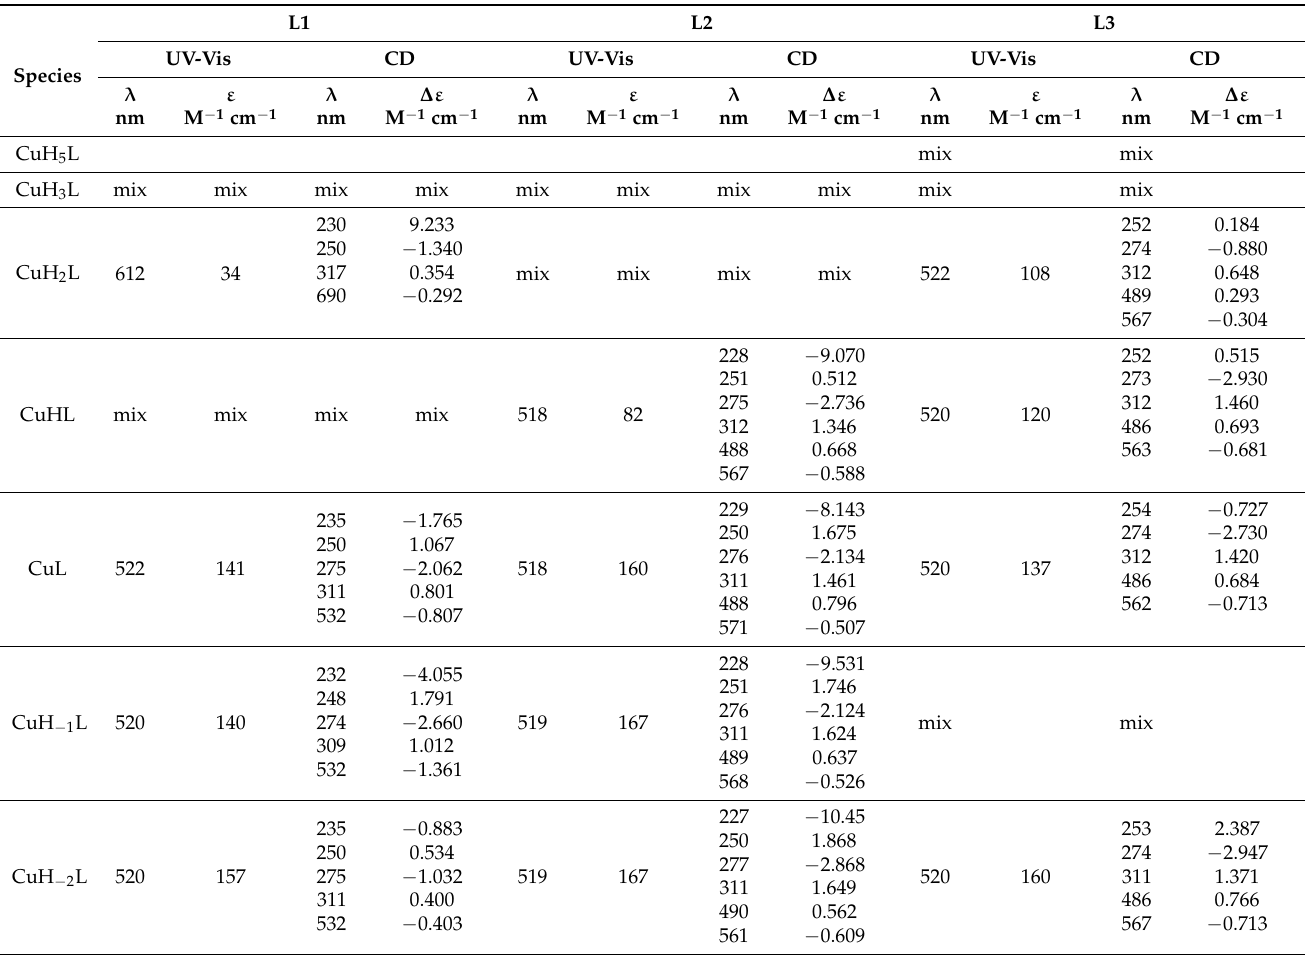
Table 3. Spectroscopic parameters of Cu(II) complexes of KSAFELPHYGLLAHQ (L1), KSHFEL- PAYGLLAHQ (L2), and KSHFELPHYGLLAHQ (L3). M(II) to peptide molar ratio, 1:1, Table